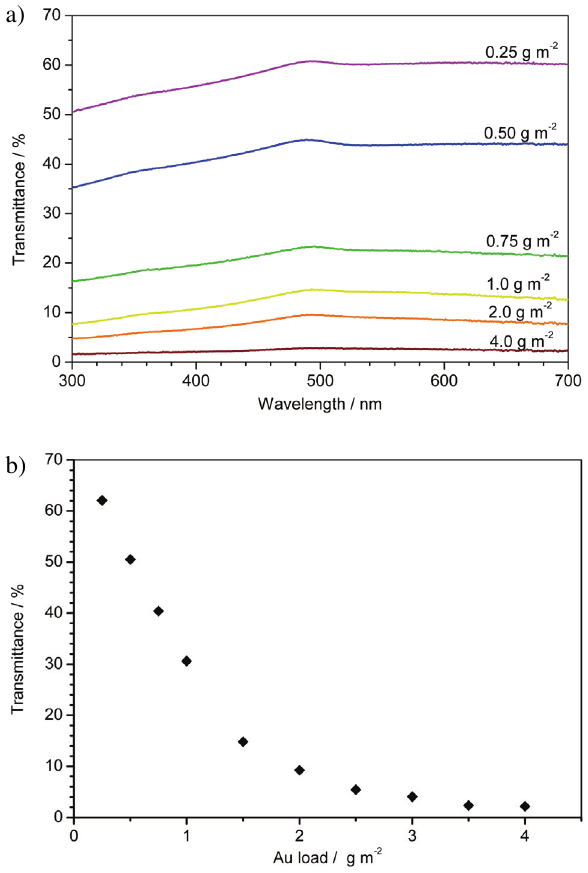
Figure 7. a) UV-vis transmittance spectra of Au thin films on glass with various Au loads. b) Transmittance of Au thin films on glass at 490 nm.